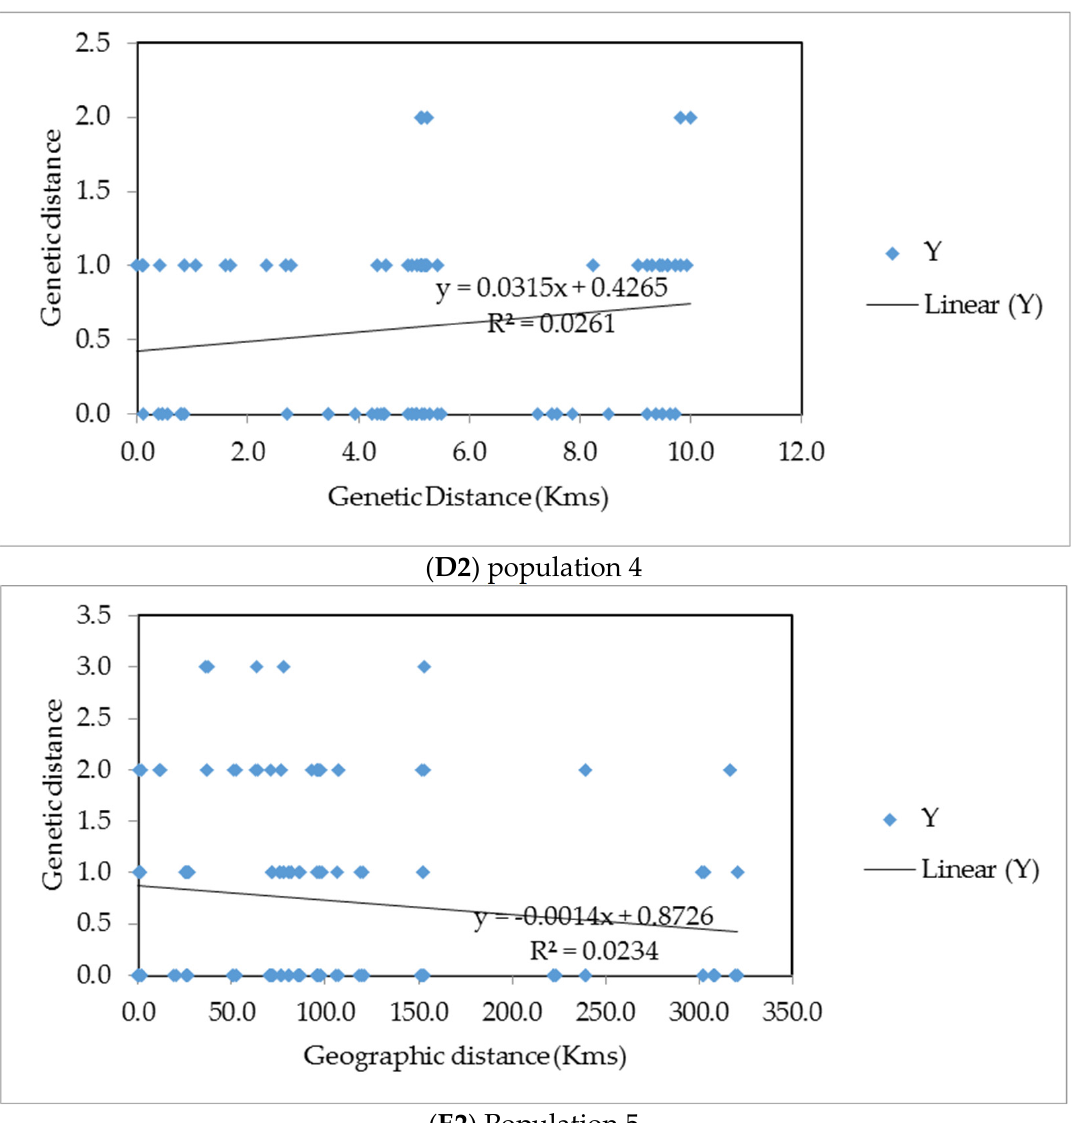
Figure 6. Correlation between geographical and genetic distances of Ootheca mutabilis samples for each independent agro-ecological zone. ( A1 , A2 ) Northern moist farmlands (Agro-ecological zone A), ( B1 , B2 ) Western mid-altitude farmlands (Agro-ecological zone B), ( C1 , C2 ) Central wooden savannah (Agro-ecological zone C), ( D1 , D2 ) Southern and Eastern Lake Kyoga basin (Agro-ecological zone D) and ( E1 , E2 ) North-western farmlands (Agro-ecological zone E). ( A1 , B1 , C1 , D1 , E1 ) represent SSR data and ( A2 , B2 , C2 , D2 , E2 ) represent mt COI partial gene data.